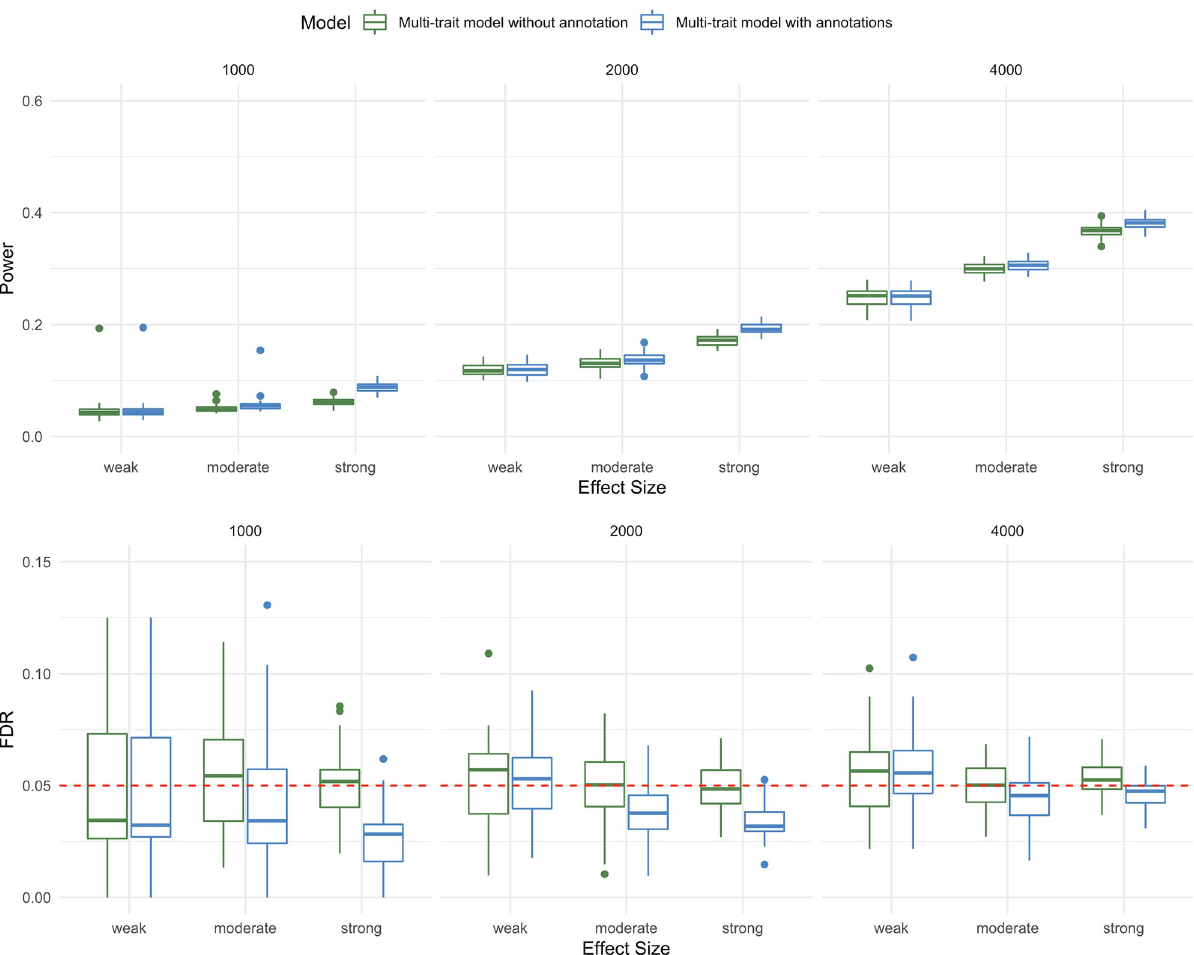
Fig 4. Power and FDR of M-DATA under model misspecification. The top panel and bottom panel show the power and FDR under weak, moderate , l 2 { 00, 01, 10, 11 } respectively. For each panel, each plot from left to right represents study sample and strong annotations on the latent variables Z il size of 1000, 2000, and 4000, respectively. Each scenario is replicated for 50 times in our